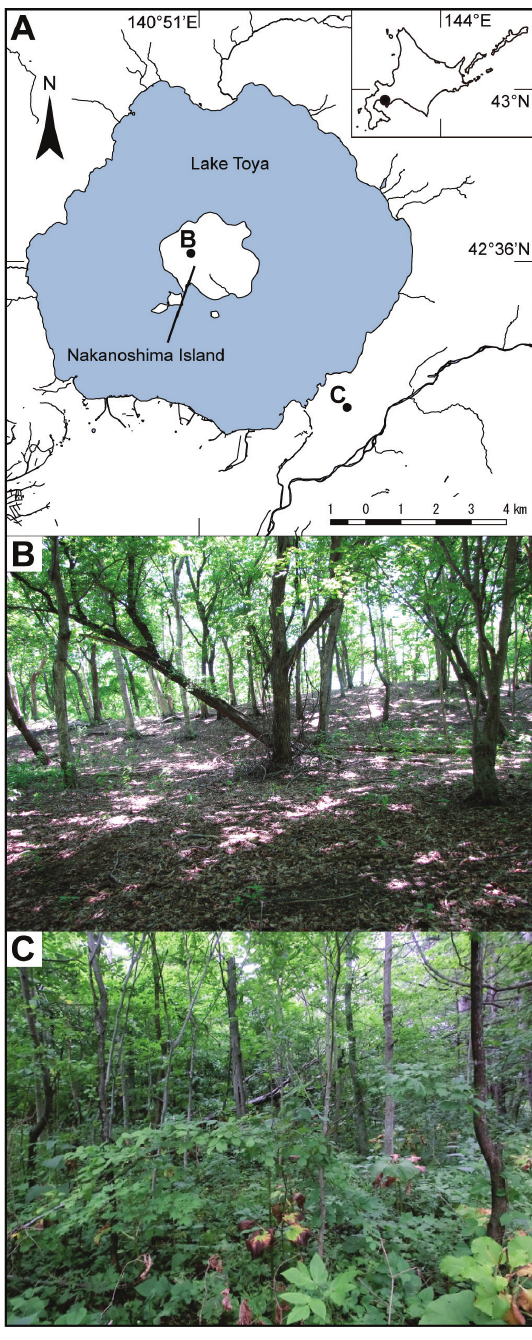
Figure 1. The location and forest floor of the study area. A The location of Lake Toya B Forest floor of Nakanoshima Island C Forest floor of the lakeshore of Lake Toya. The map of Lake Toya was modified from the Geospatial Information Authority of Japan